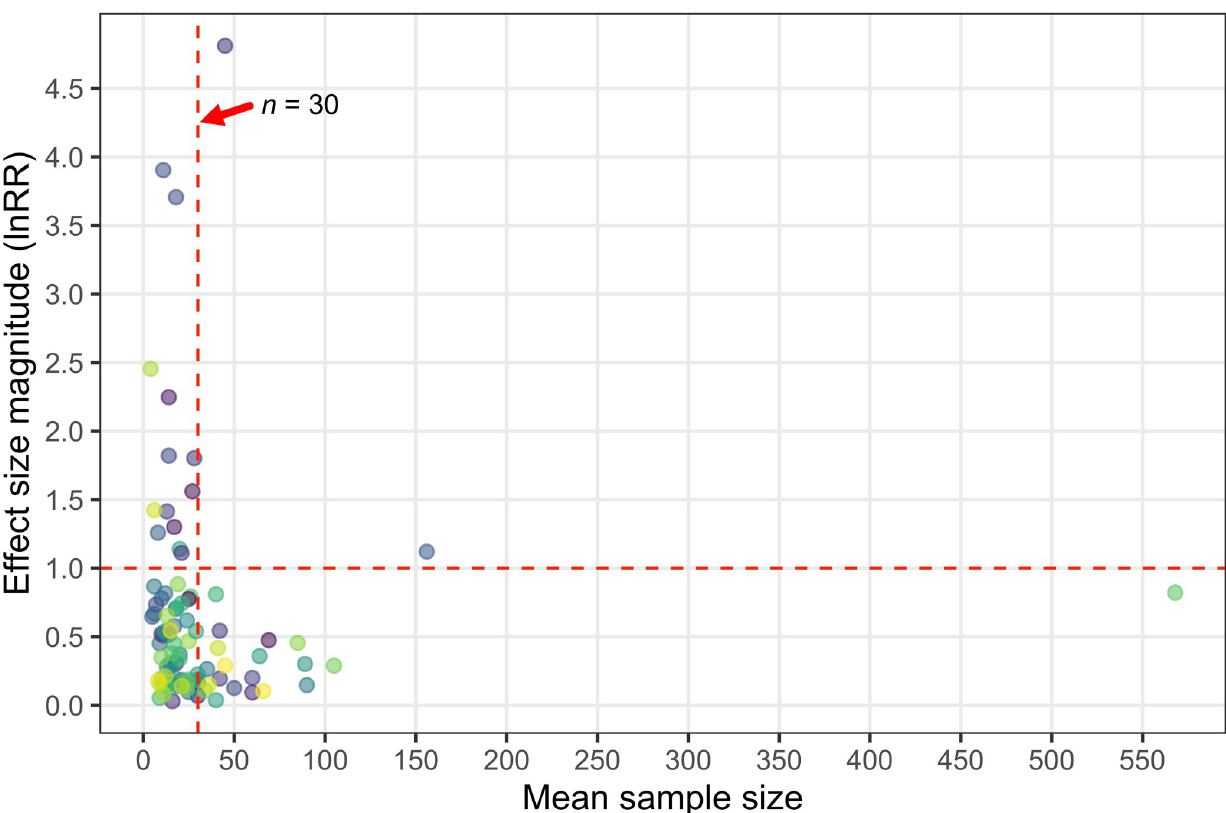
Fig 3. Studies with large effect sizes tend to have low samples sizes. Mean effect size magnitude (absolute lnRR) for each study as a function of the mean sample size of that study (i.e., sample size per experimental treatment). Note that mean effect size for a given study is not a weighted effect size magnitude, but is simply computed as the mean of individual effect size magnitudes for a given study. The vertical red dashed line denotes a sample size of 30 fish, while the horizontal red dashed line represents a lnRR magnitude of 1. Source data for each figure panel can be found in S1 Data.